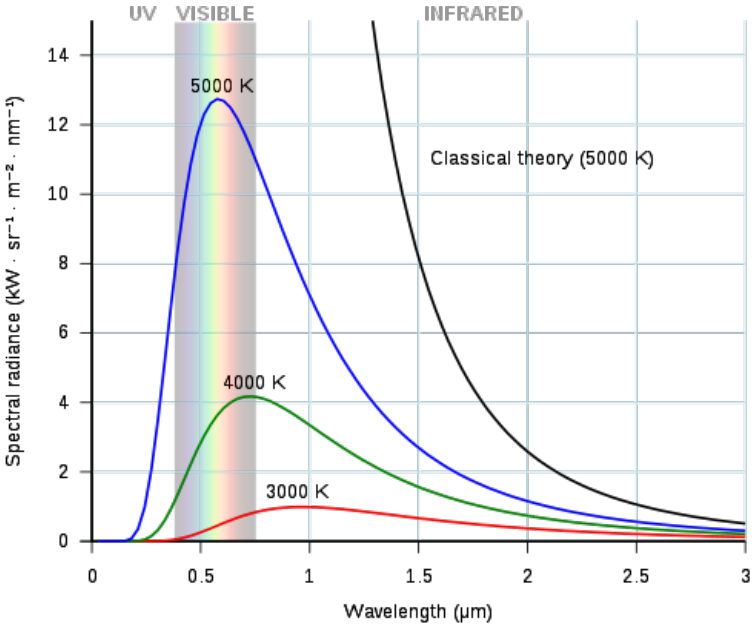
Figure 1. Radiance of blackbodies for various